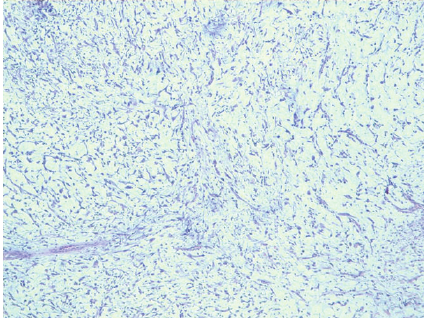
Figure 4: HESX10: atypical spindle cells proliferation arranged in a myxoid